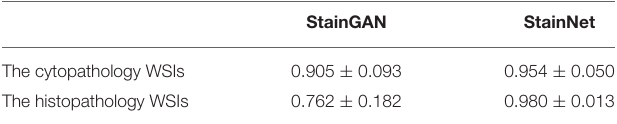
TABLE 4 | The SSIM source of the normalized whole slide image by StainGAN and